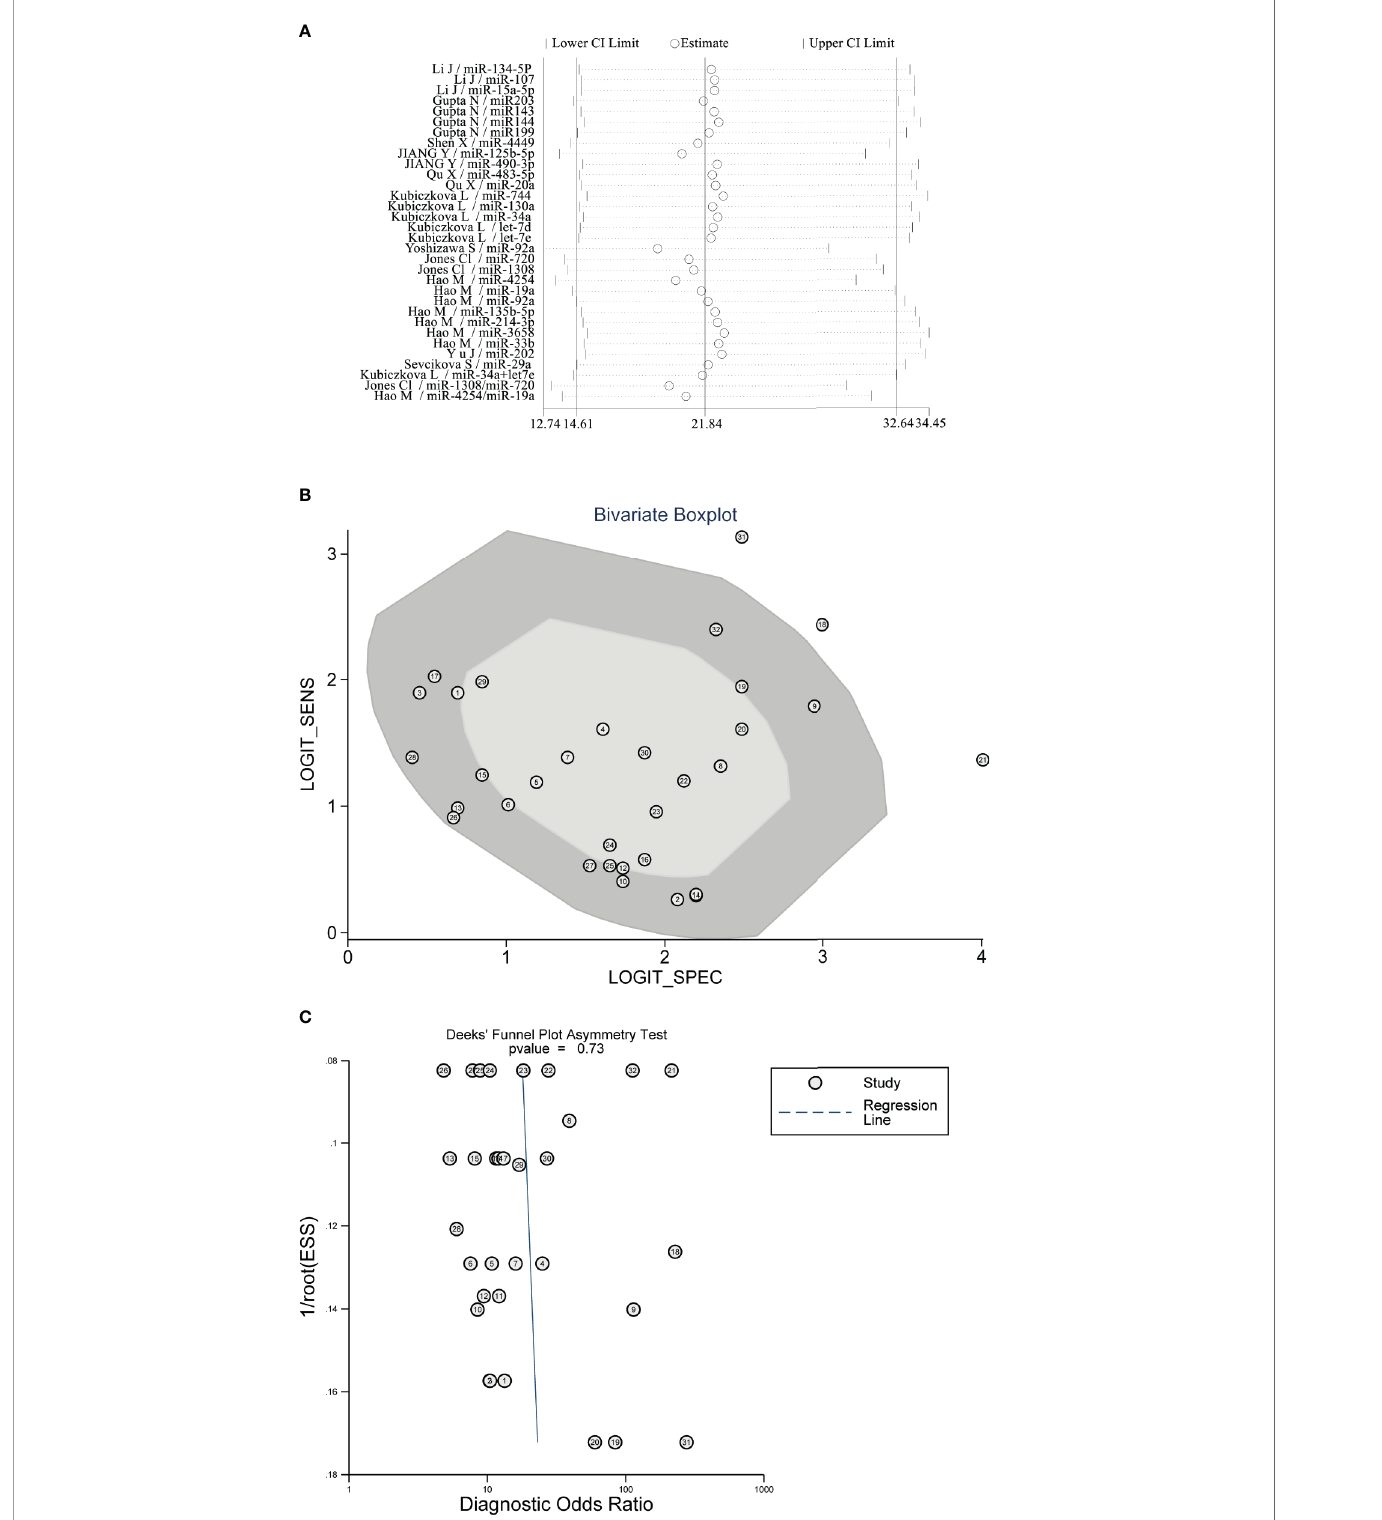
FIGURE 5 | Sensitivity analysis and Heterogeneity exploration. (A) Sensitivity Analysis showed that the combination results were stable; (B) Bivariate Boxplot revealed that No.18/21/31 studies presented strong heterogeneity; (C) Deek ’ s Funnel Plot Asymmetry Test found no publication